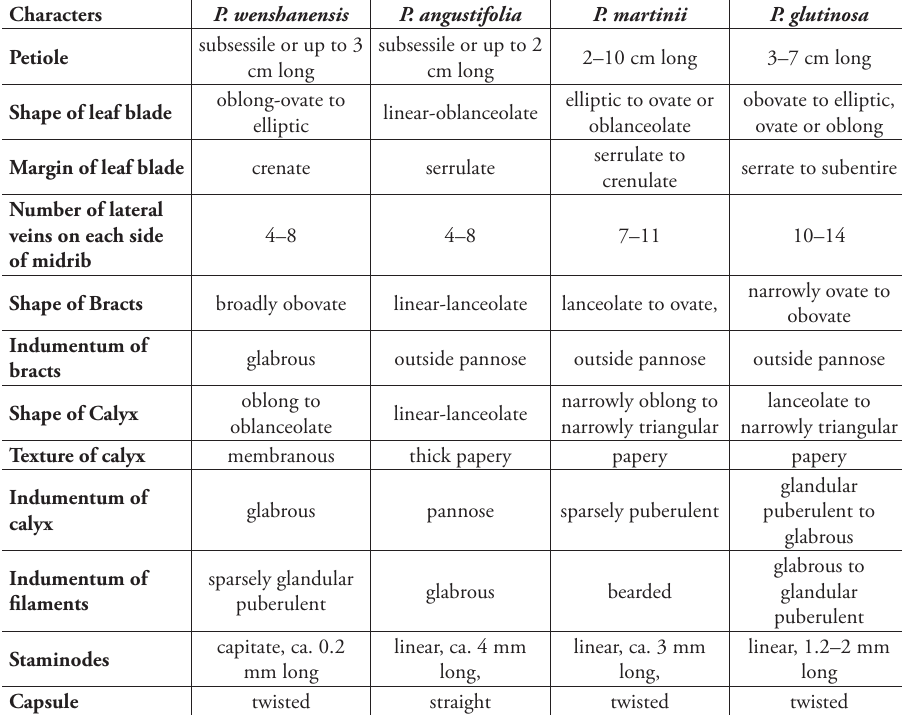
Table 1. Diagnostic character differences amongst Paraboea wenshanensis sp. nov., P. angustifolia , P. mar- tinii and P. glutinosa